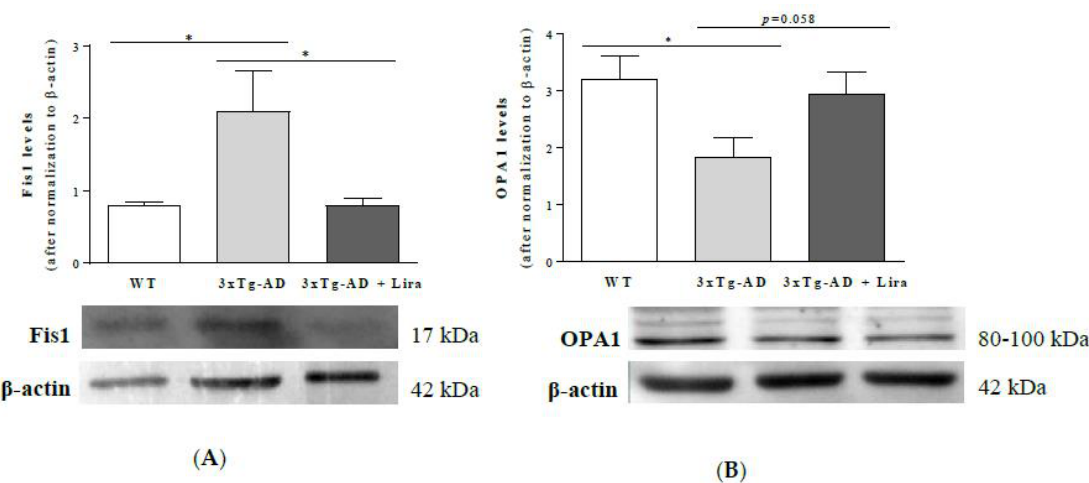
Figure 7. Effect of liraglutide on brain cortical mitochondrial fission/fusion markers in female mice with early AD-like pathology. Brain cortical Fis1 ( A ) and OPA1 protein levels ( B ) were determined and normalized to β-actin levels, and representative Western blotting images displayed. Data are the mean ± SE from 6 mice/group. Statistical significance: * p < 0.05, by the one-way ANOVA with the Fisher LSD post-hoc test for multiple comparisons.